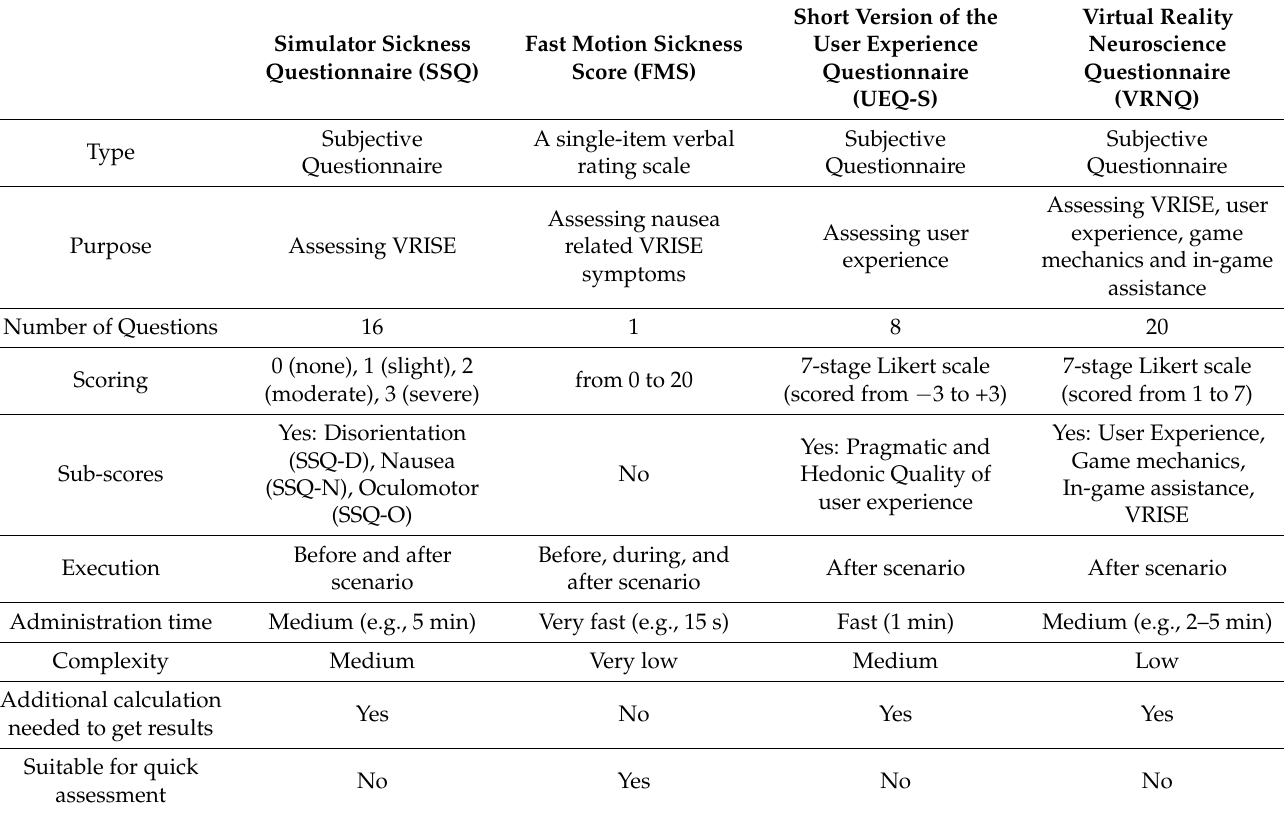
Table 1. Comparison of used metrics (questionnaires) in the